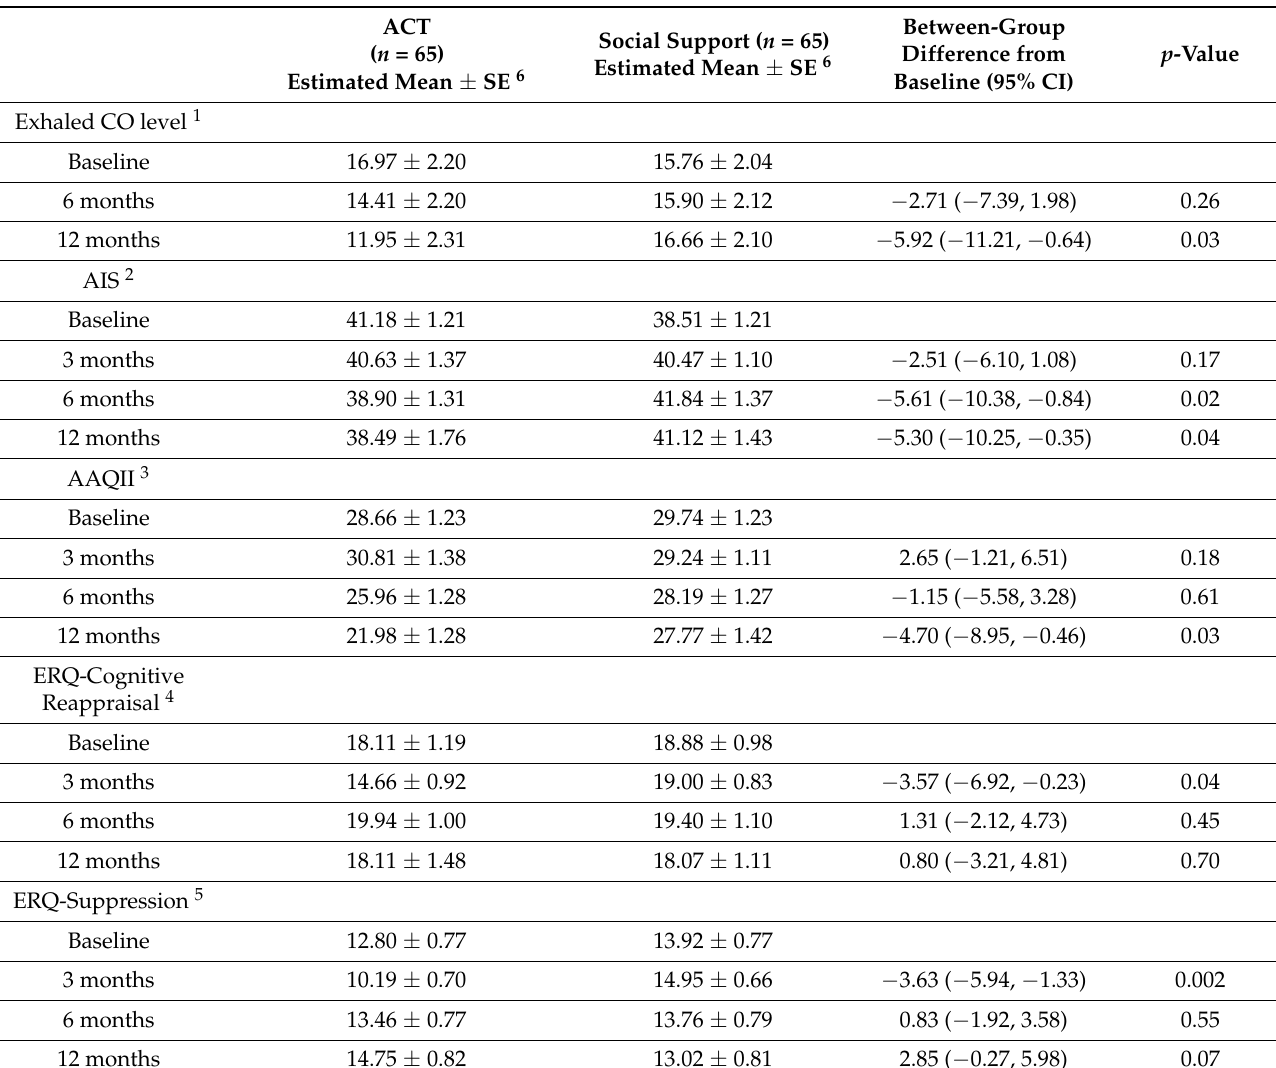
Table 3. GEE results on changes in process measures over time by